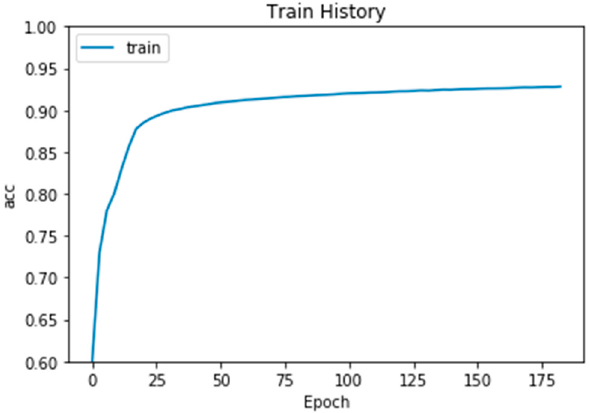
Figure 9. Multilayer perceptron (MLP) model.